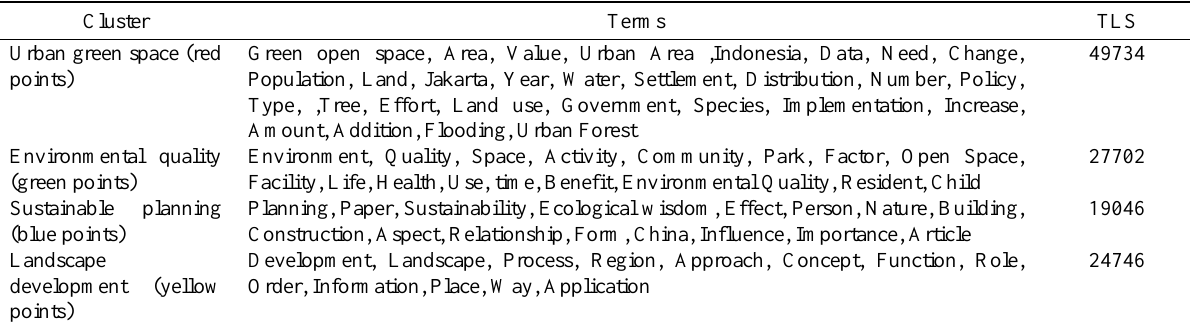
Table 1. The Most Relevant Term n Green Open Space and Ecological Wisdom Research Cluster Terms TLS Urban green space (red Green open space, Area, Value, Urban Area ,Indonesia, Data, Need, Change, points) Population, Land, Jakarta, Year, Water, Settlement, Distribution, Number, Policy, Type, ,Tree, Effort, Land use, Government, Species, Implementation, Increase, Amount, Addition, Flooding, Urban